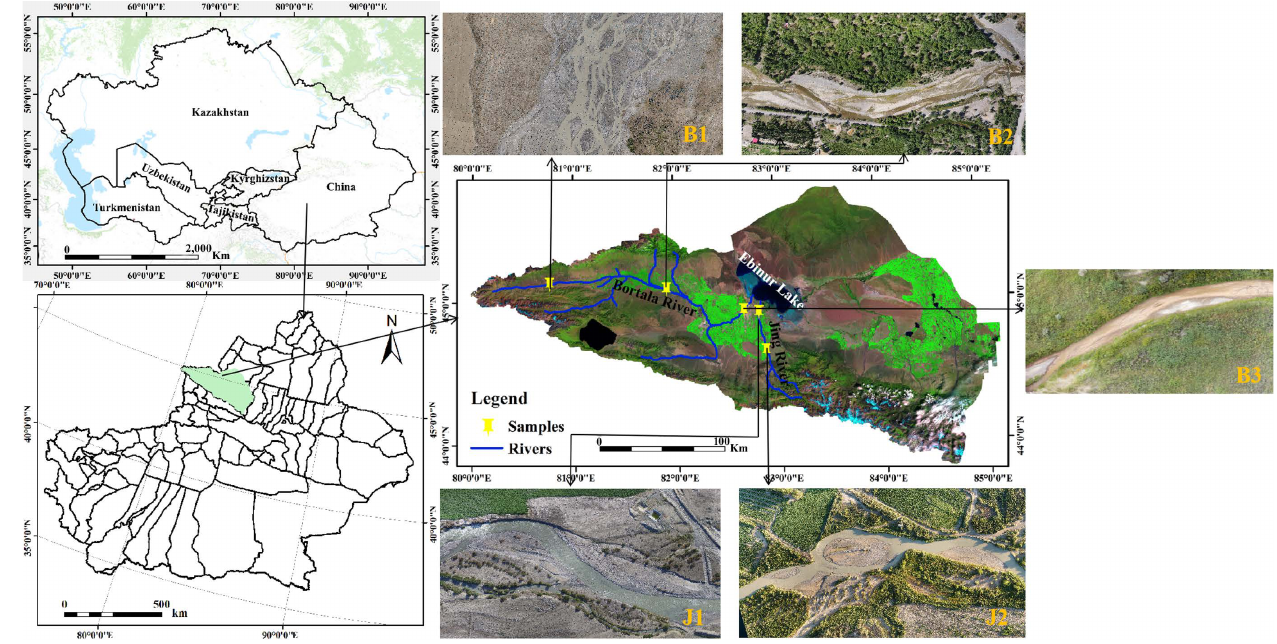
Figure 1. Location and river-course cross-section photos of the study